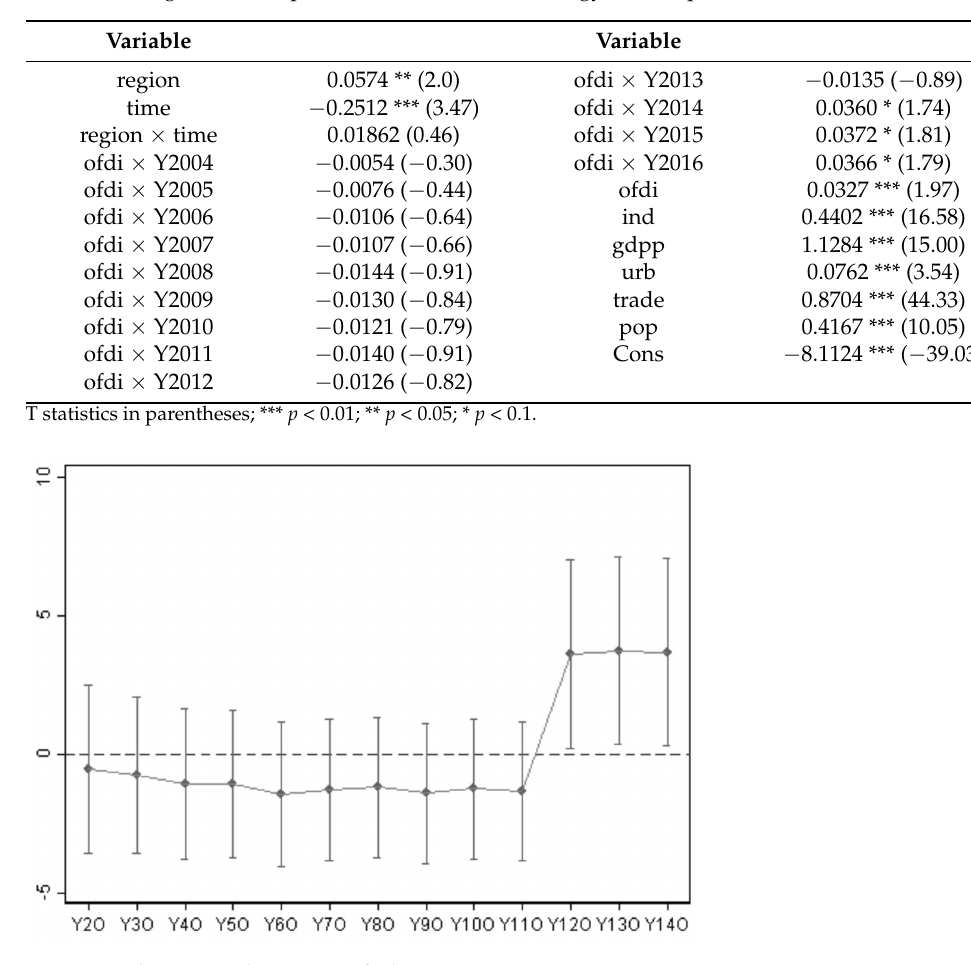
Table 8. Changes in the impact of China’s OFDI on energy consumption.